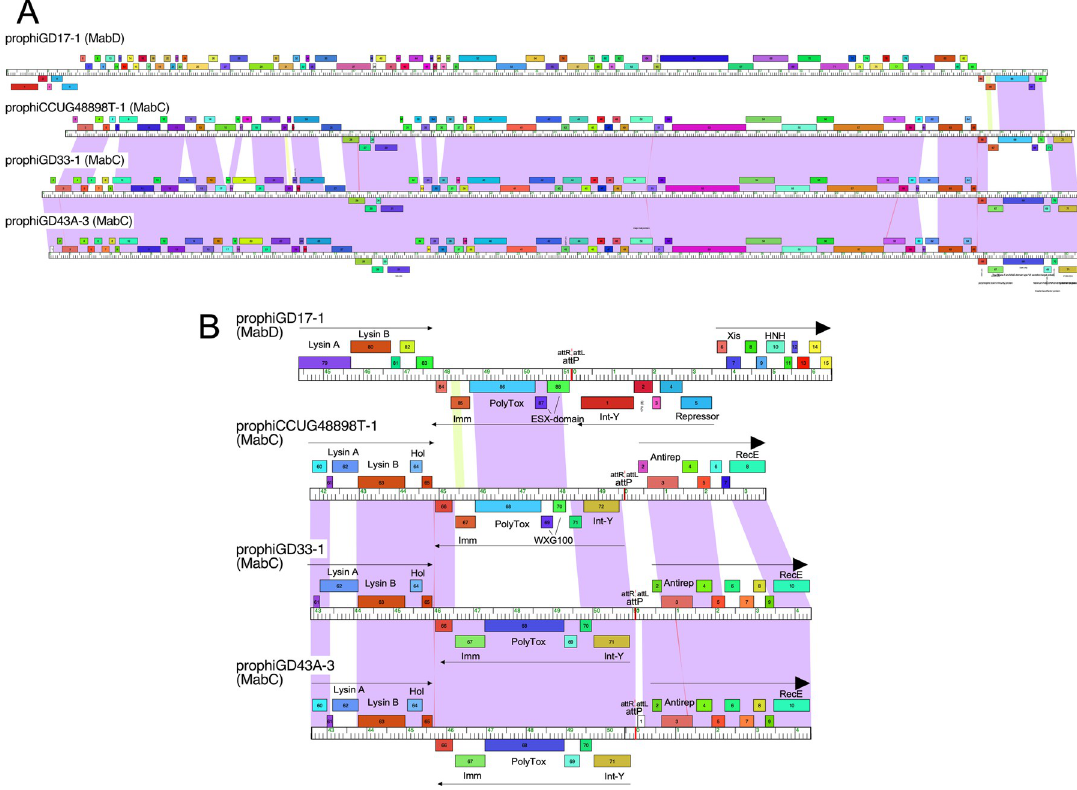
Fig 6. Swapping of polymorphic toxin-immunity systems between MabC and MabD genomes. A. Genome maps for prophiGD17-1, prophiCCUG48898T-1, prophiGD33-1, and prophiGD43A-3 are displayed. The top genome (prophiGD17-1) is in Cluster MabD, whereas the other three genomes are grouped into Cluster MabC. Genomes are displayed as in Fig 3. B . Exchange of the polymorphic toxin-immunity cassette between MabD and MabC phages. Genomes are represented as in panel A, with gene numbers shown inside gene boxes, and the directions of transcription noted by horizontal arrows. The color of each box reflects its gene phamily assignment, based on similar amino acid sequences [41]. Each genome segment shows the fusion of the extreme right end to the extreme left end of the genome, reconstituting attP and the organization as it would be represented in the parent phage genome. Note that MabC prophage prophiCCUG48898T-1 does not share nucleotide sequence similarity with the MabD prophage prophiGD17-1 except for genes 68 – 70 .